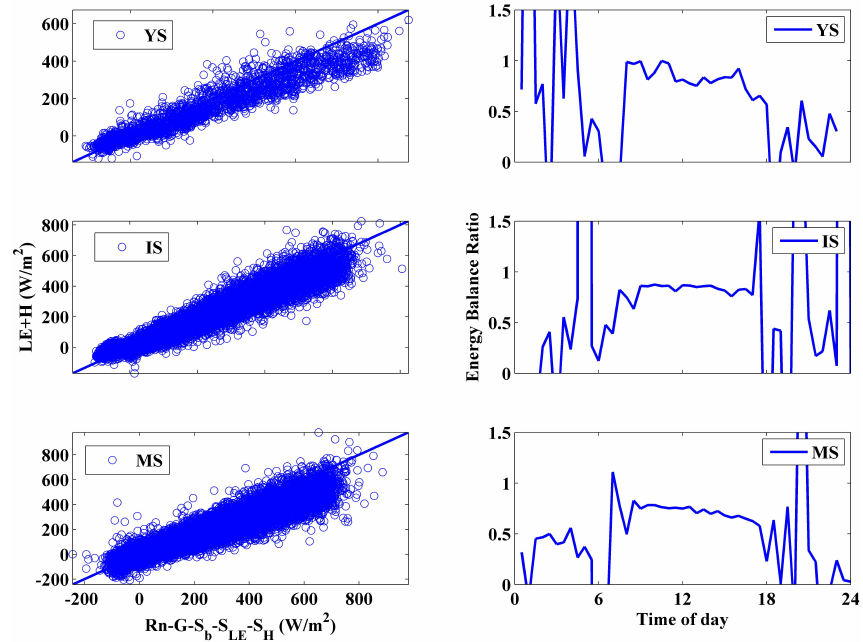
Fig. A1. Left side: relationship between the measured turbulent fluxes (y-axis) and the available energy (x-axis) at the three stands YS (top), IS (middle) and MS (bottom) from 2001 to 2008. Right side: variability of the average energy balance ratio during the day.